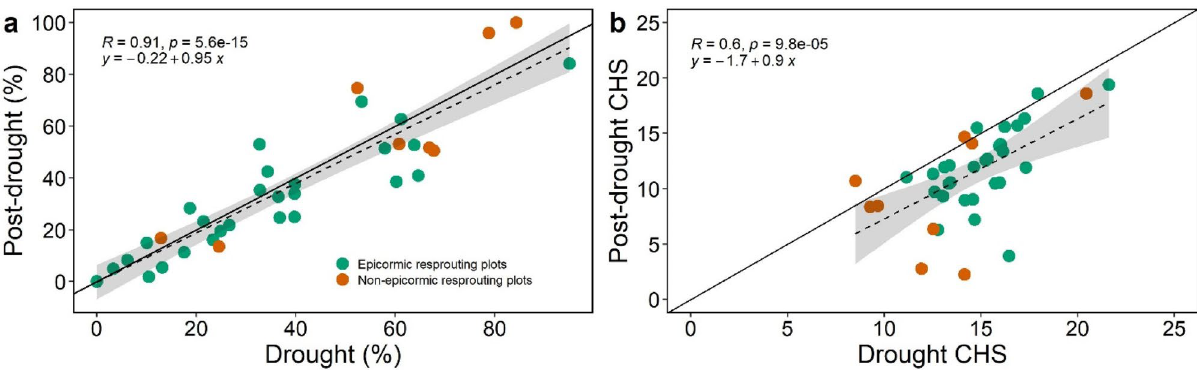
Figure 6. Plots of percentage of tree basal area exhibiting browning scores ≤ 1 ( a ), and weighted basal-area Canopy Health Score (CHS; b ) measured during drought and post-drought at each plot under study. Colors indicate epicormic (green) and non-epicormic (orange) dominant plots. Dashed line shows linear regression, solid line shows 1:1 line. The grey shaded area is the confidence interval of the regression